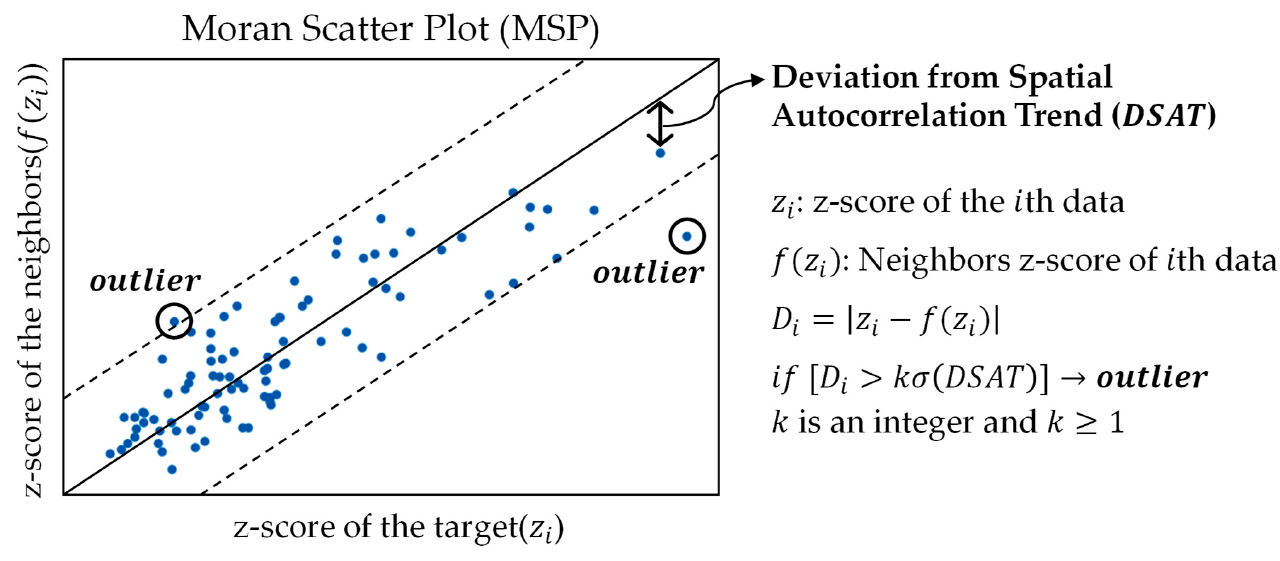
Figure 5. Outlier detection using deviation from the spatial autocorrelation trend (DSAT).